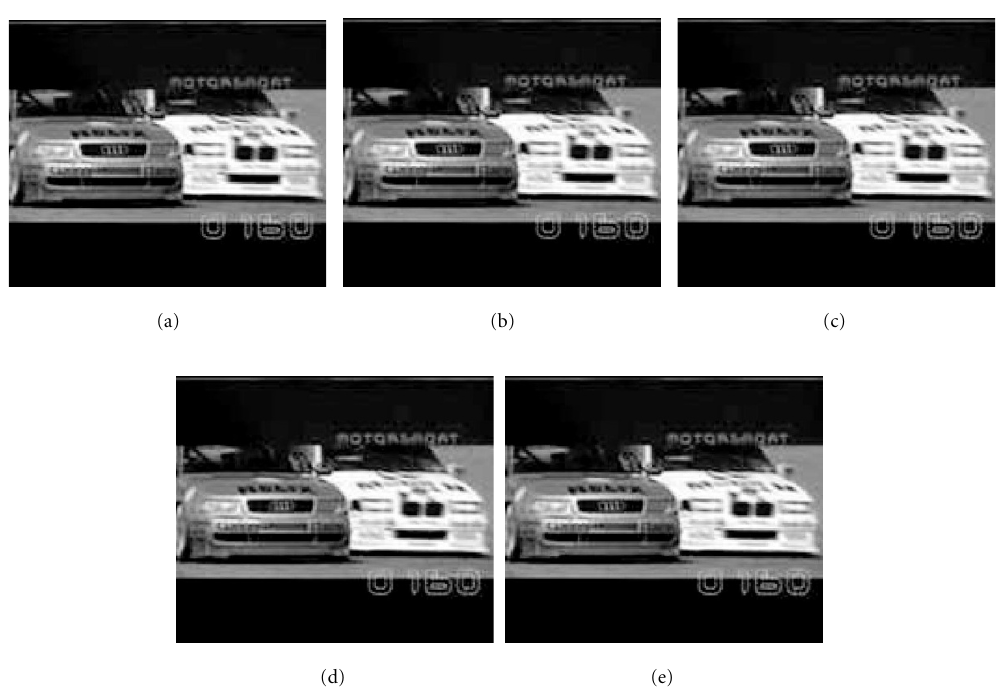
Figure 6: The 55th estimated frames for the Rallycross sequence using di ff erent searching algorithms. Estimated frames using (a) FS, (b) DS, (c) 4SS, (d) NTSS, and (e) HS.